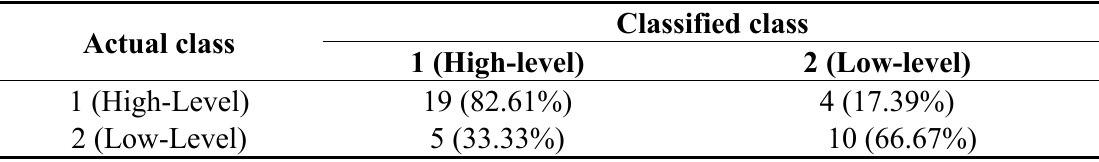
Table 12. RST-DEA-NB model (model IX) results with both significant variables and DMU.